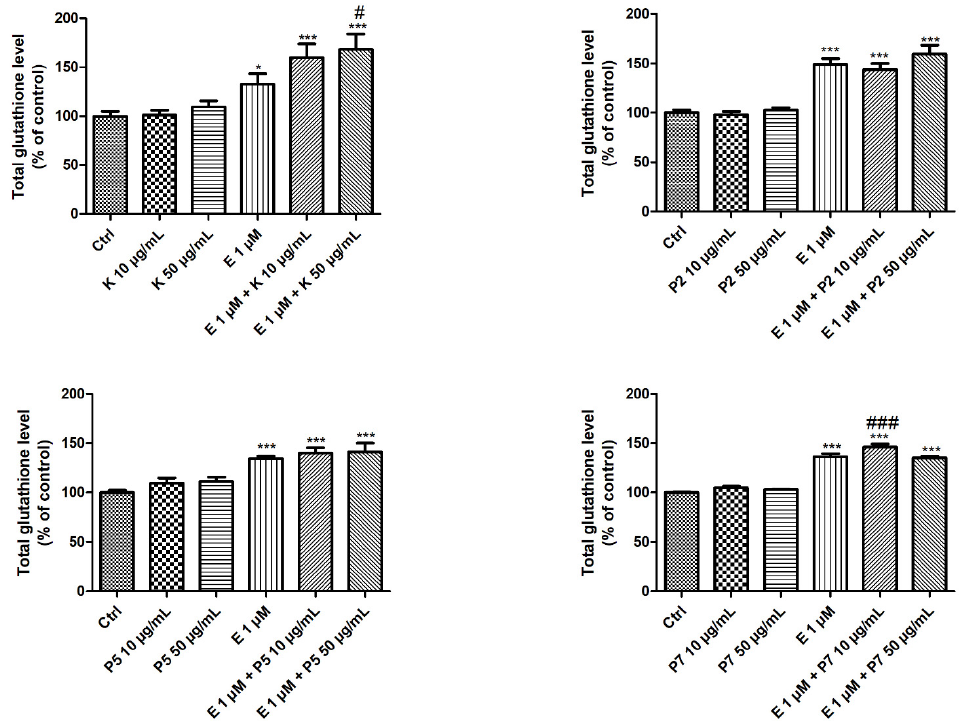
Figure 3. The total glutathione level in HL-60 cells incubated for 24 h at 37 ° C with 10–50-µg/mL kaempferol (K), P2, P5, P7, and/or 1-µM etoposide (E). The figure shows the mean results ± SD, n = 3; * p < 0.05, and *** p < 0.001 vs. control (Ctrl); # p < 0.05, and ### p < 0.001 vs. etoposide (E). Data were normalized to the negative control, which was assigned as 100% of the glutathione level.